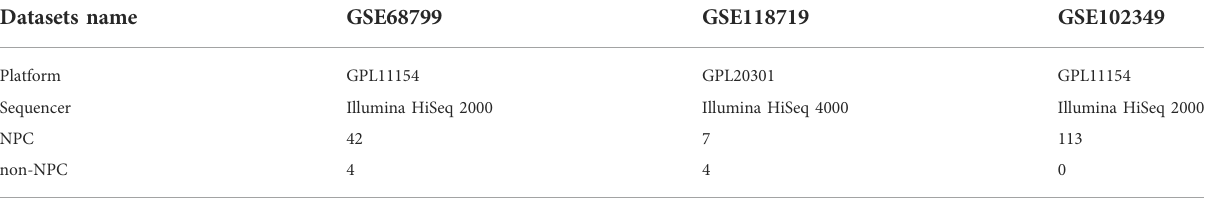
TABLE 1 The basic information of the three